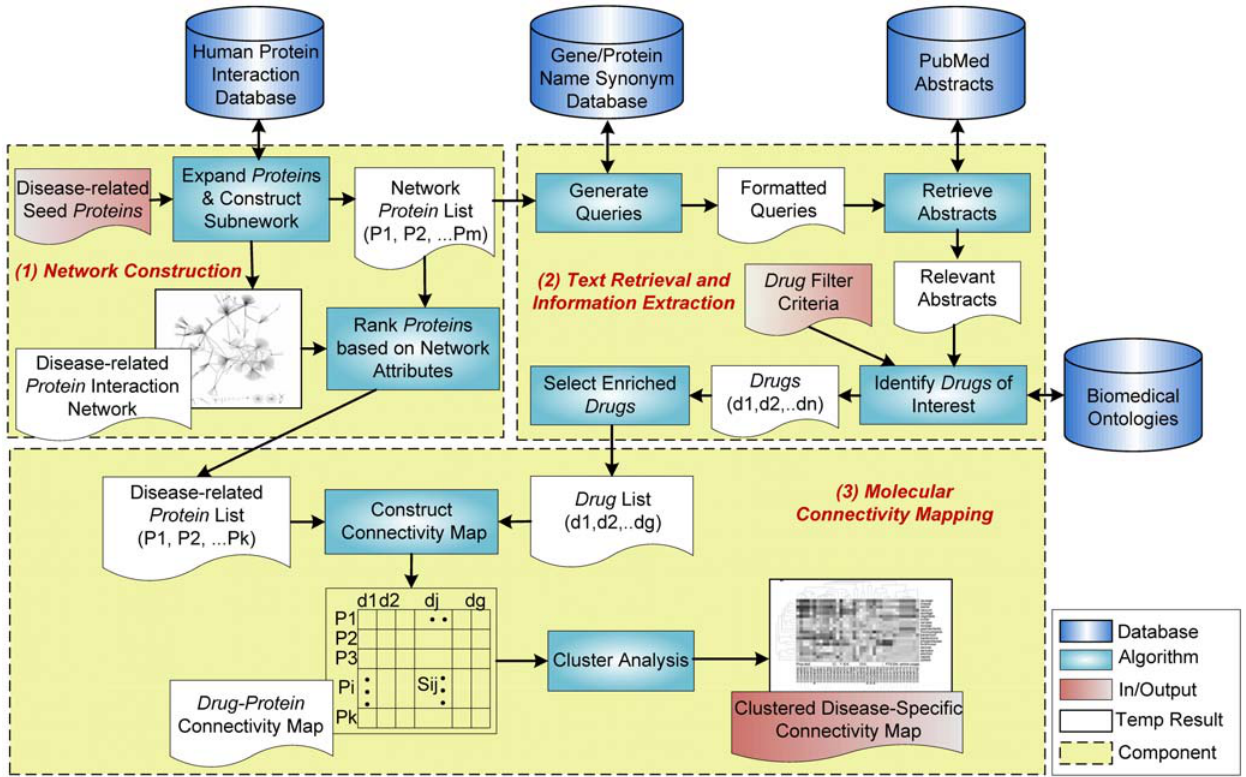
Figure 2. A computational framework for developing molecular connectivity maps in any given disease context. The framework consists of three components: network construction , text retrieval and information extraction , and molecular connectivity mapping . The network construction component takes the inputs of disease-specific seed proteins and outputs a disease-related protein interaction network with a ranked list of disease-related proteins. The text retrieval and information extraction component takes synonym-expanded disease-related proteins and outputs a list of drug terms enriched in the retrieved collection of PubMed abstracts. The molecular connectivity mapping component takes two inputs—disease-related proteins from constructed protein interaction network in the first component, and enriched drug terms in the second component—and outputs a drug-protein connectivity map, in which further knowledge filters and clustering analysis can be applied.